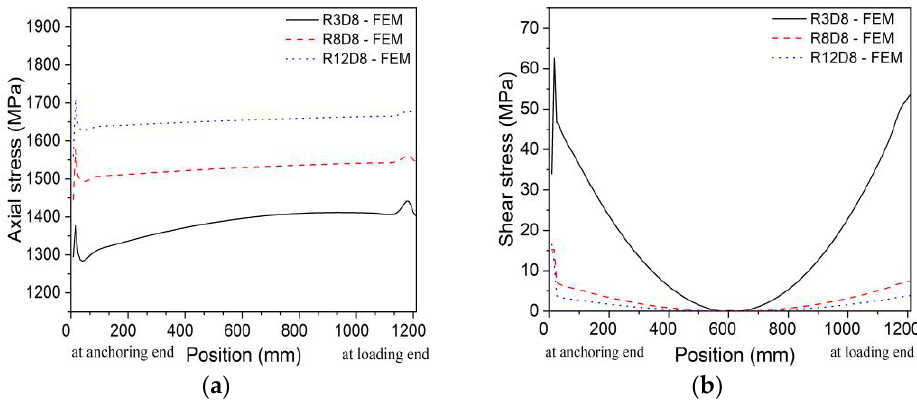
Figure 14. Effect of bending radius on the stress distributions of CFRP tendons: ( a ) axial stress; ( b ) shear stress.